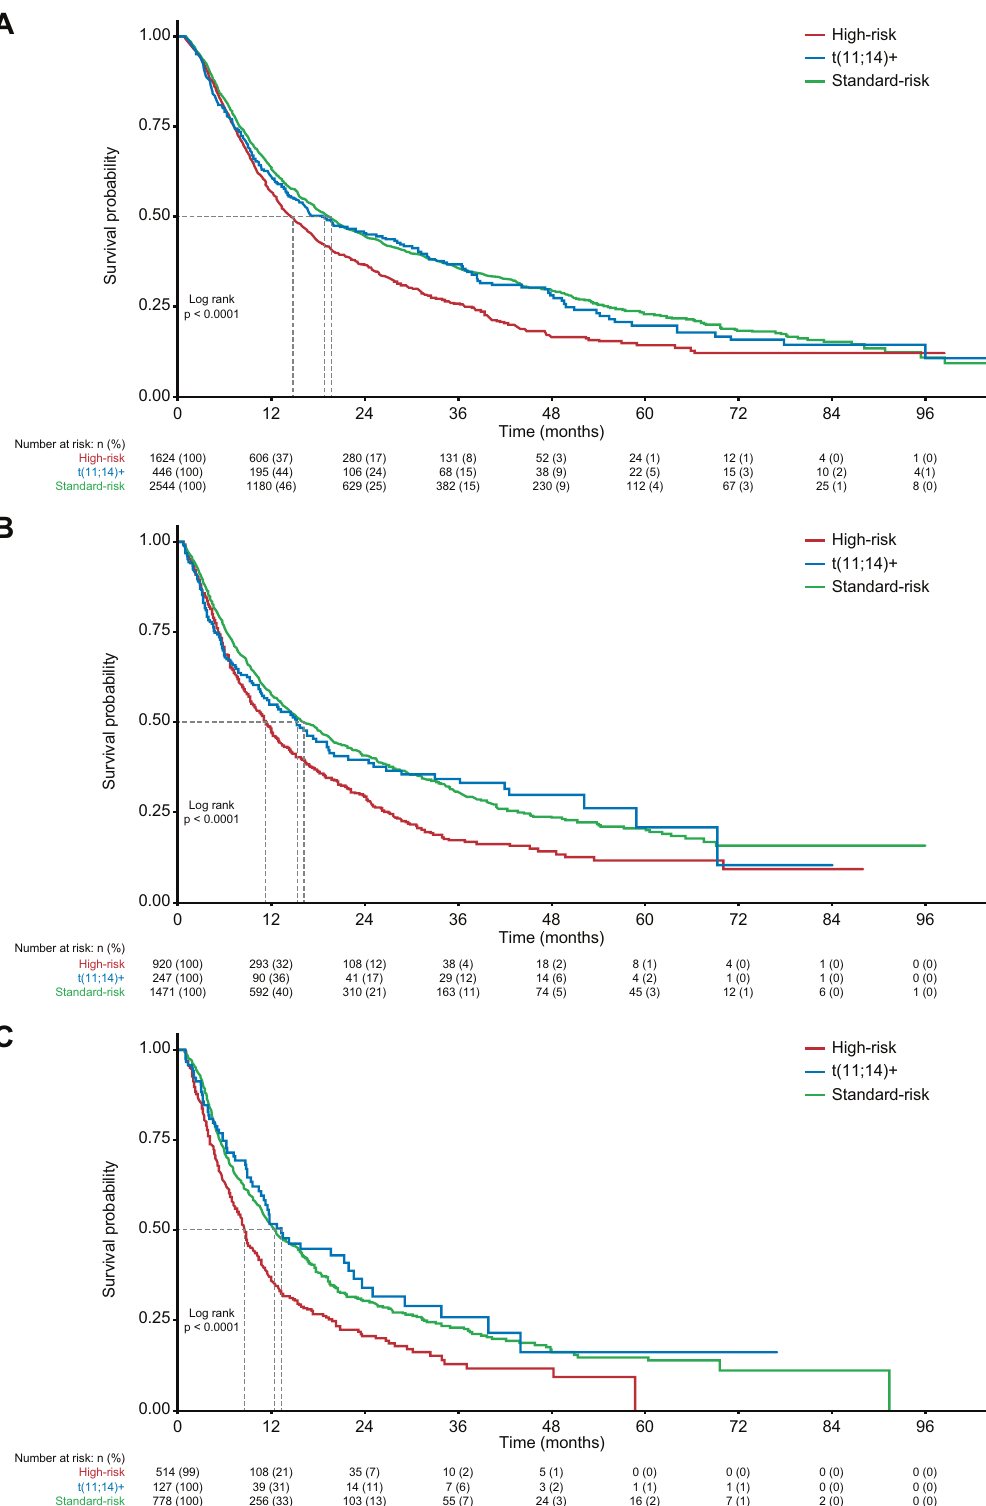
during this time are considered equally; thus, any treatment paradigm shifts that occurred due to new approvals of treatment regimens or updates to the initially approved indications (e.g.,